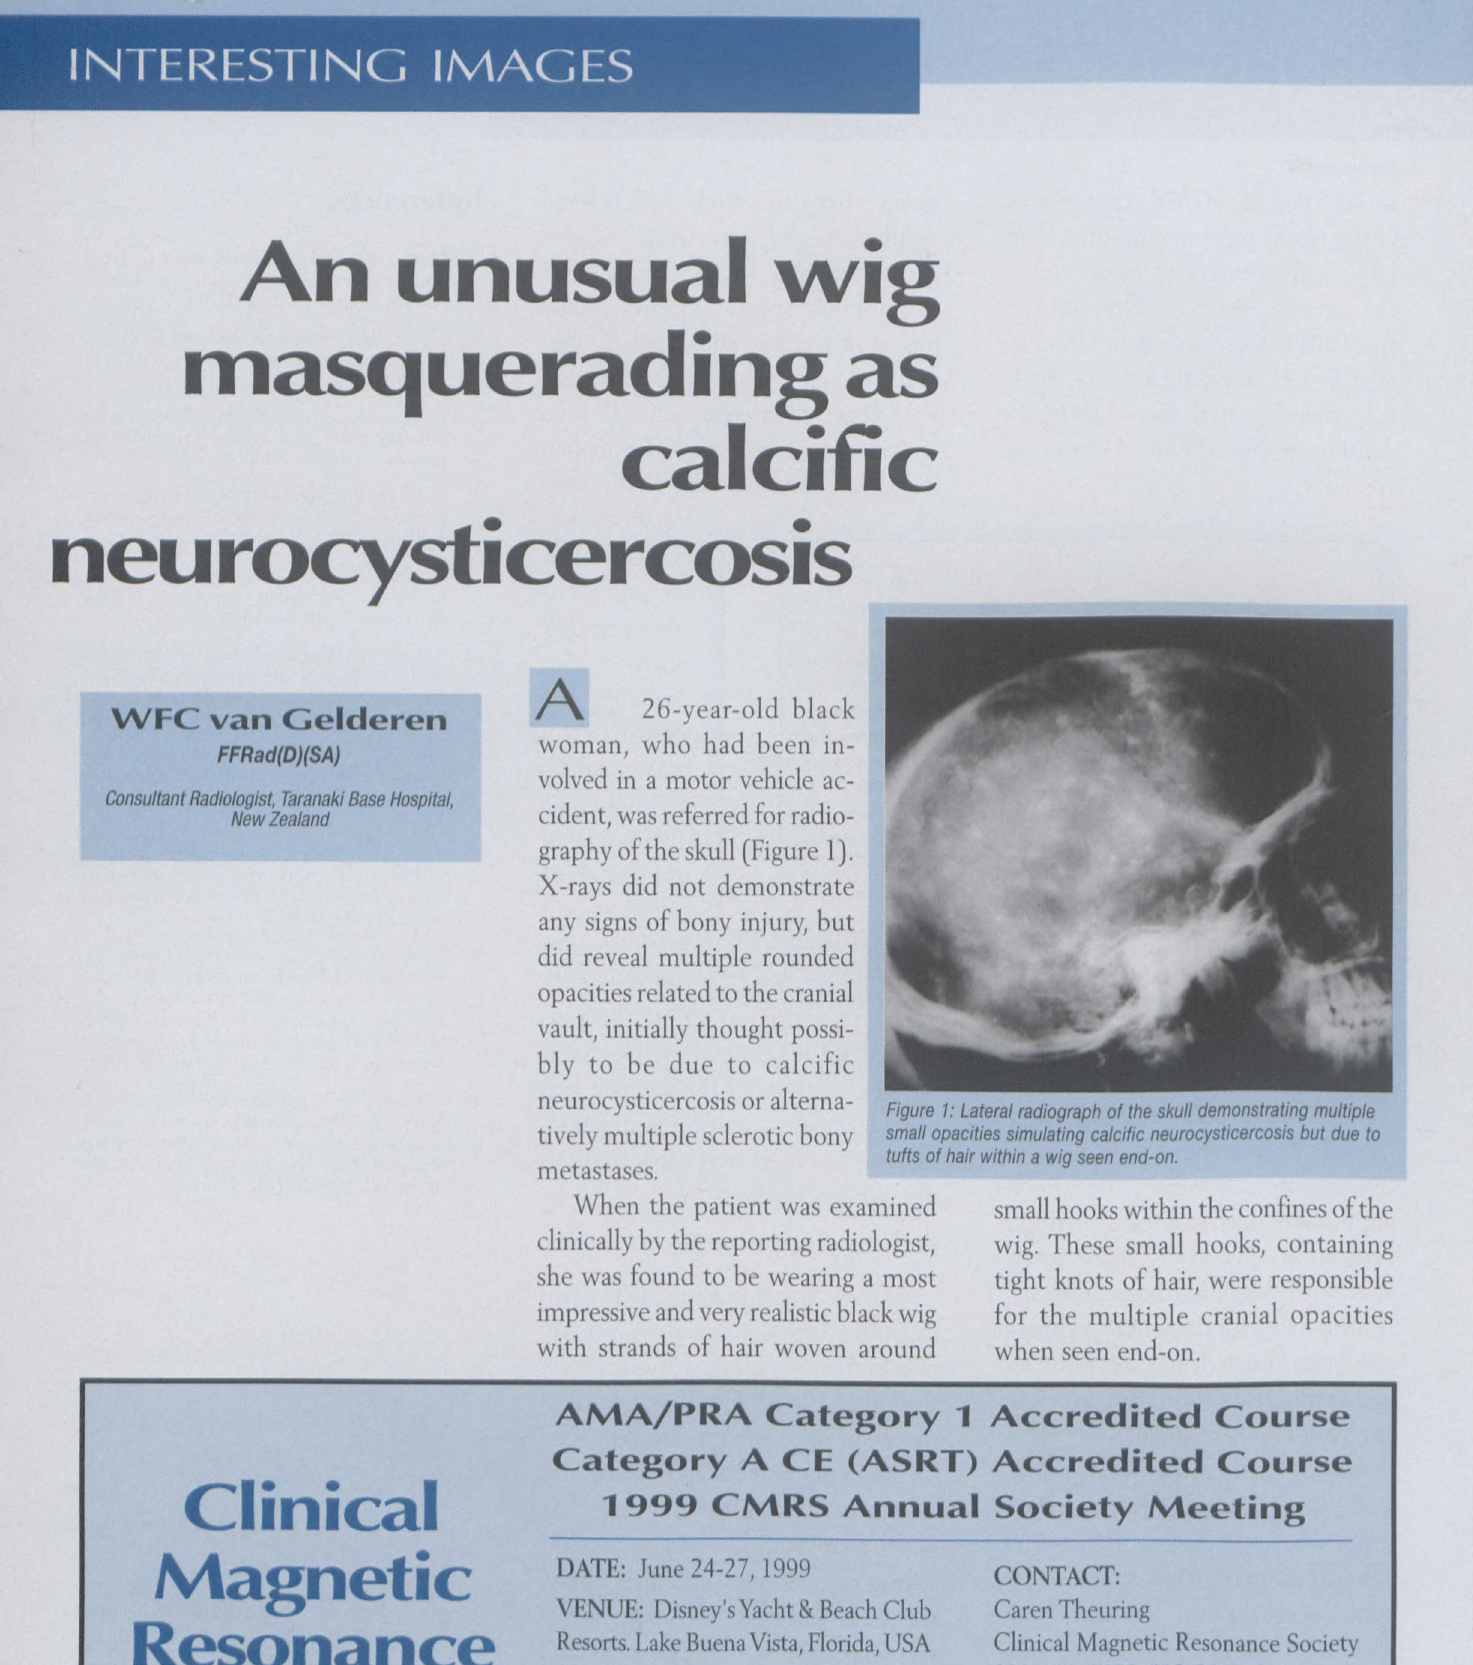
Figure 1: Lateral radiograph of the skull demonstrating multiple small opacities simulating calcific neurocysticercosis but due to tufts of hair within 8 wig seen end-on.